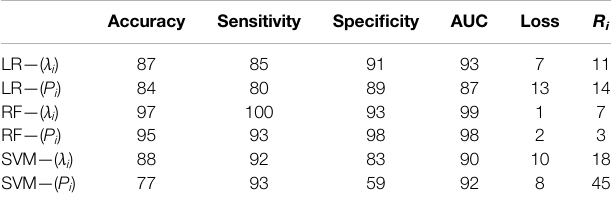
TABLE 1 | Supplementary table associated with all classi fi cation MLAs performances, where all numerical values are in %. All MLAs were trained with 7 PCsandtheirscoresfortheeigenvaluemodeland6 PCsandtheirscoresforthe IPP